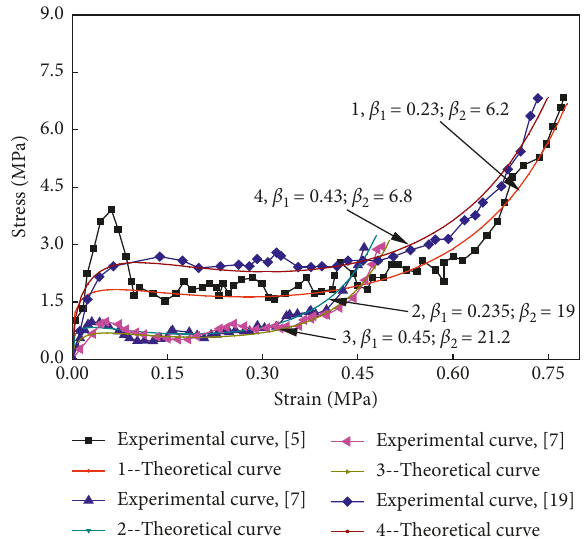
Figure 10: Experimental curves and its theoretical curves of honeycomb Table 3: The relative density of honeycomb materials and its constitutive model coefficients.